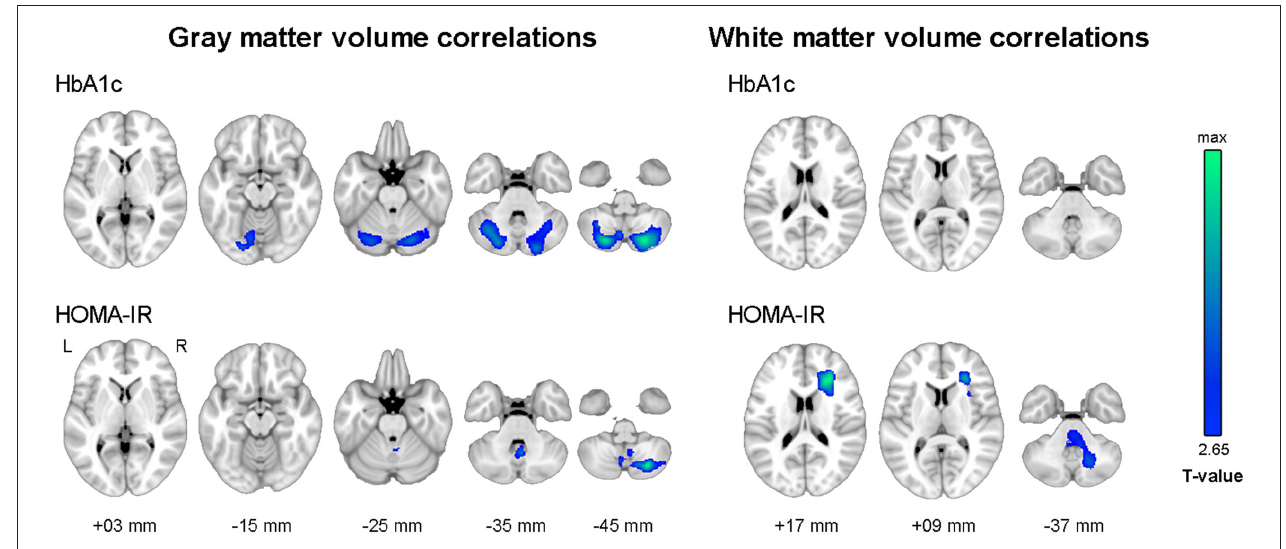
FIGURE 3 | Results of whole-brain correlation analyses between regional brain volume and diabetes biomarkers in dysglycemia. Family-wise error corrected p < 0.05 at cluster level with underlying voxel level of uncorrected p < 0.005. HbA1c, glycosylated hemoglobin level; HOMA-IR, Homeostatic Model Assessment for Insulin